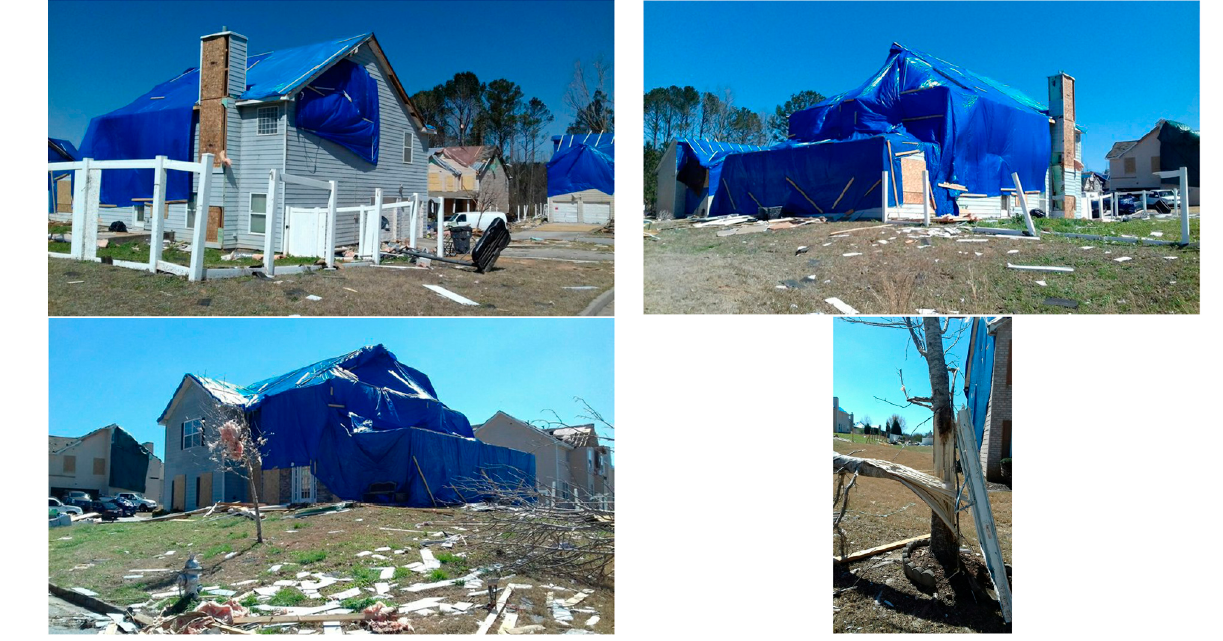
Figure 5. Damages in Fairburn, Georgia, 2018 [Foto made by authors of the article].